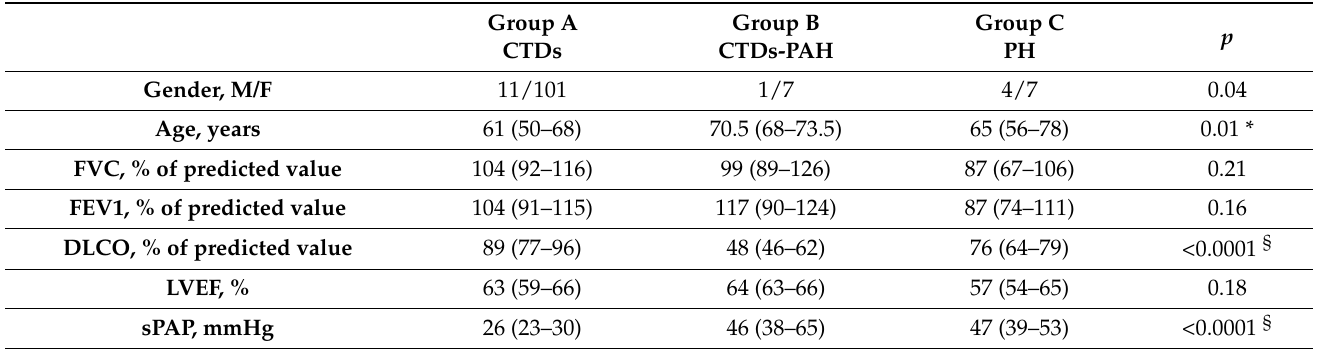
Table 1. Main general features of the study population and comparison between groups. For abbreviation: CTDs, connective tissue diseases; PAH, pulmonary arterial hypertension; PH, pulmonary hypertension; M, males; F, females; FVC, forced vital capacity; FEV1, forced expiratory volume in the 1st second; DLCO, diffusing capacity of the lung for carbon monoxide; LVEF, left ventricular ejection fraction; sPAP, systolic pulmonary arterial pressure. *A vs. B; § A vs. B and